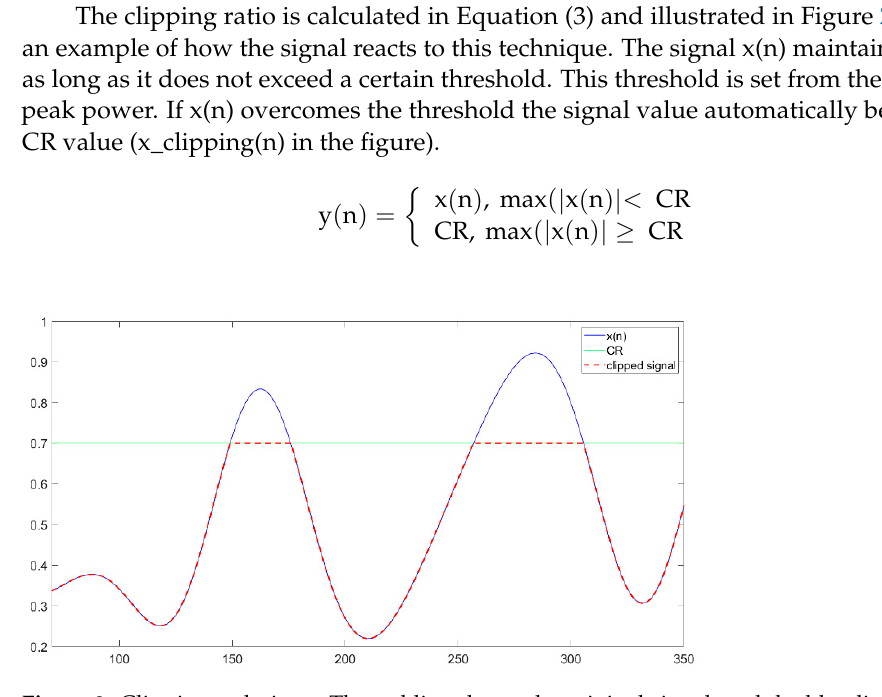
Figure 2. Clipping technique. The red line shows the original signal, and the blue line shows the clipped signal due to the threshold drawn in green [42].